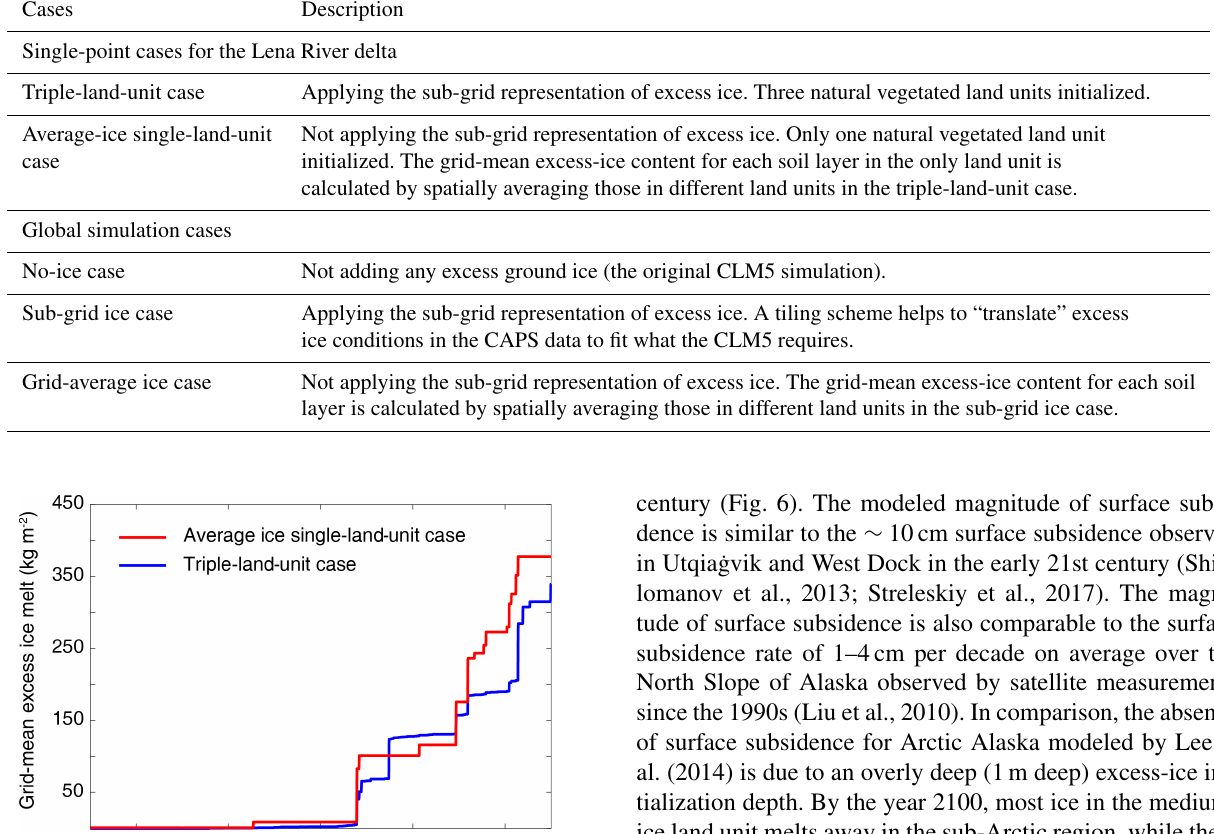
Table 3. List of simulations conducted for this study. Cases